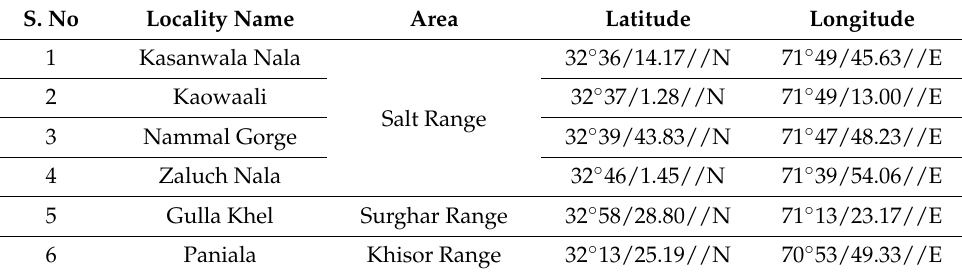
Table 2. Geographic positions of the studied sections in the Salt and Trans Indus